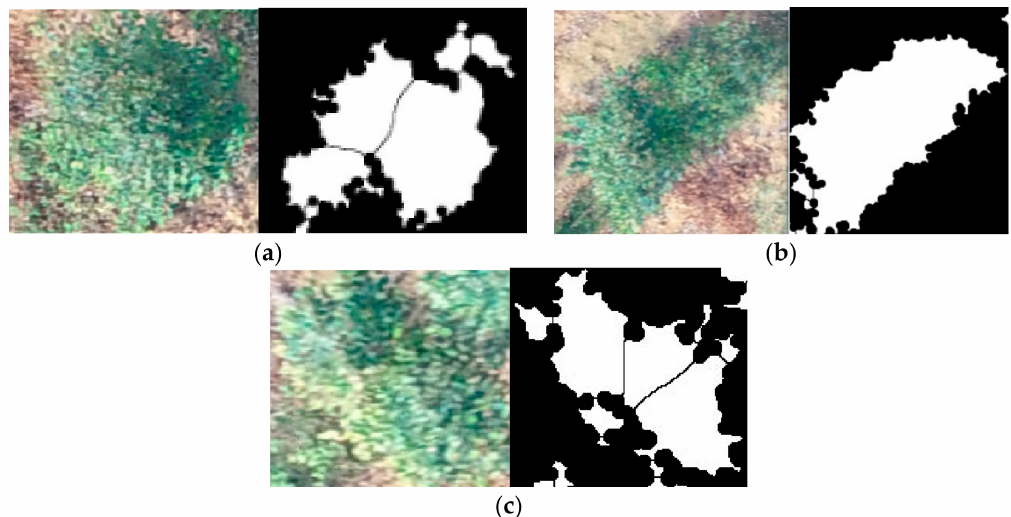
Figure 11. The results of incorrect segmentation obtained with the watershed method: ( a ) over-segmentation; ( b ) under- segmentation; ( c ) two seedlings from one